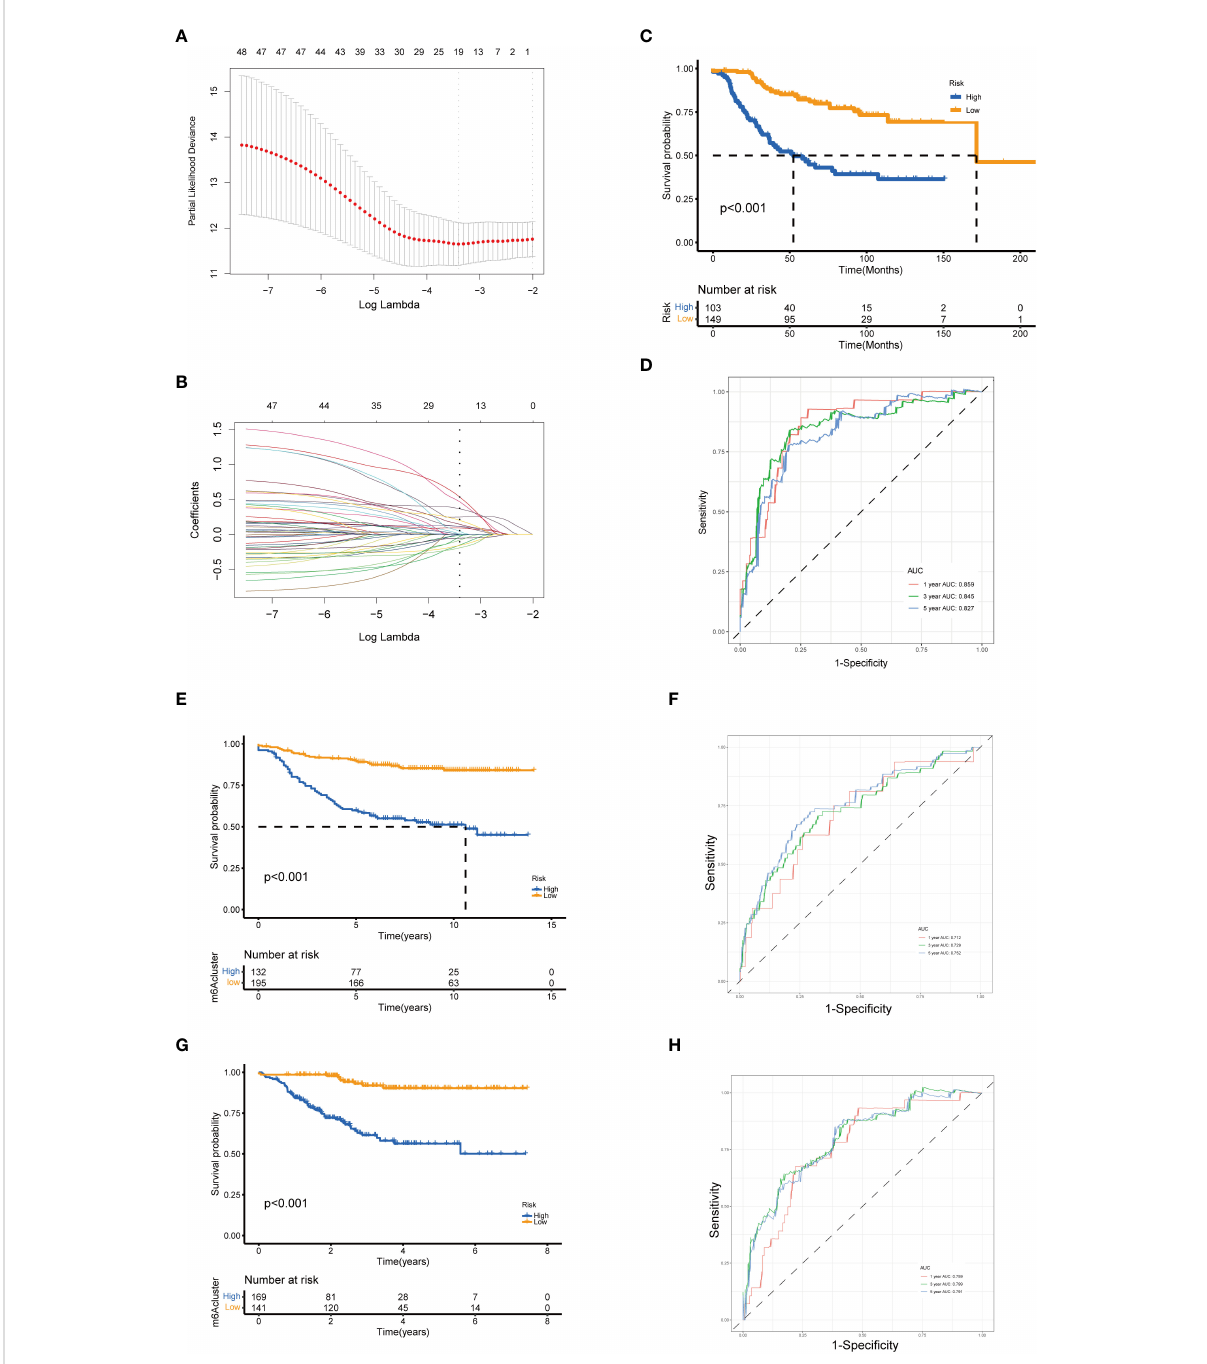
FIGURE 4 Identi fi cation and validation of the senescence-related gene model. (A) Tenfold cross-validation for tuning parameter selection in the LASSO model. (B) LASSO coef fi cient pro fi les of the 19 prognostic genes. A vertical line is drawn at the value chosen by the 10 ‐ fold cross ‐ validation RFS. Kaplan – Meier curves for the RFS of the two gene subtypes in GSE21653 (C) , GSE20685 (E) , and GSE25055 (G) (log-rank tests, p < 0.001). ROC curves to predict the sensitivity and speci fi city of 1-, 3-, and 5-year survival according to the risk score in GSE21653 (D) , GSE20685 (F) , and GSE25055 (H) . LASSO, least absolute shrinkage and selection operator; RFS, recurrence-free